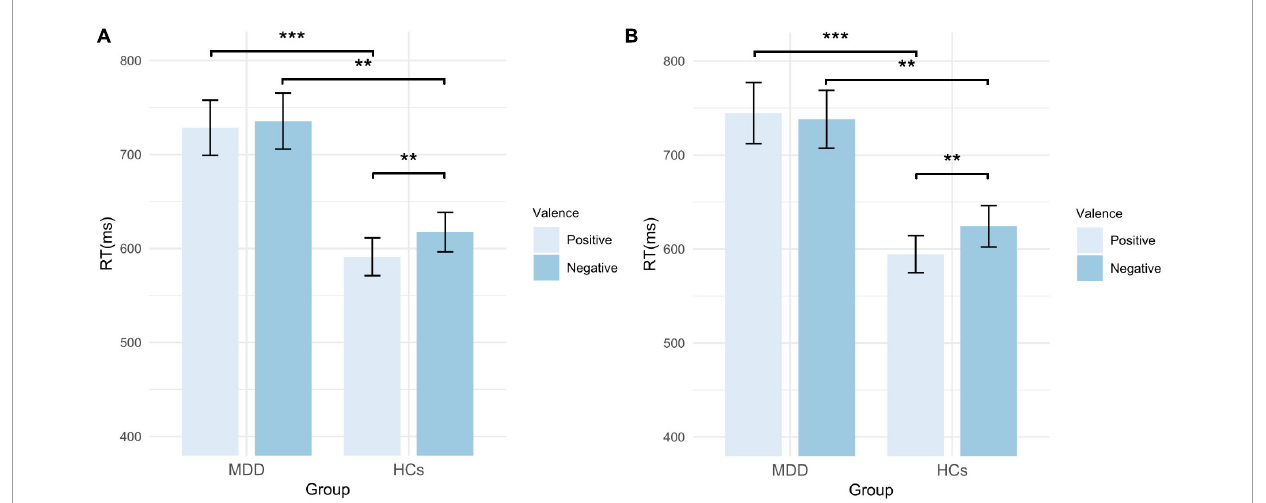
FIGURE2 RTs of MDD patients and HCs in EAST. (A) RTs of self-words; (B) RTs of other-words. MDD, major depressive disorder; HCs, healthy controls; RT, reaction time; EAST, External Affect Simon Task; error bars represent the standard error. ** p < 0.01; *** p < 0.001.